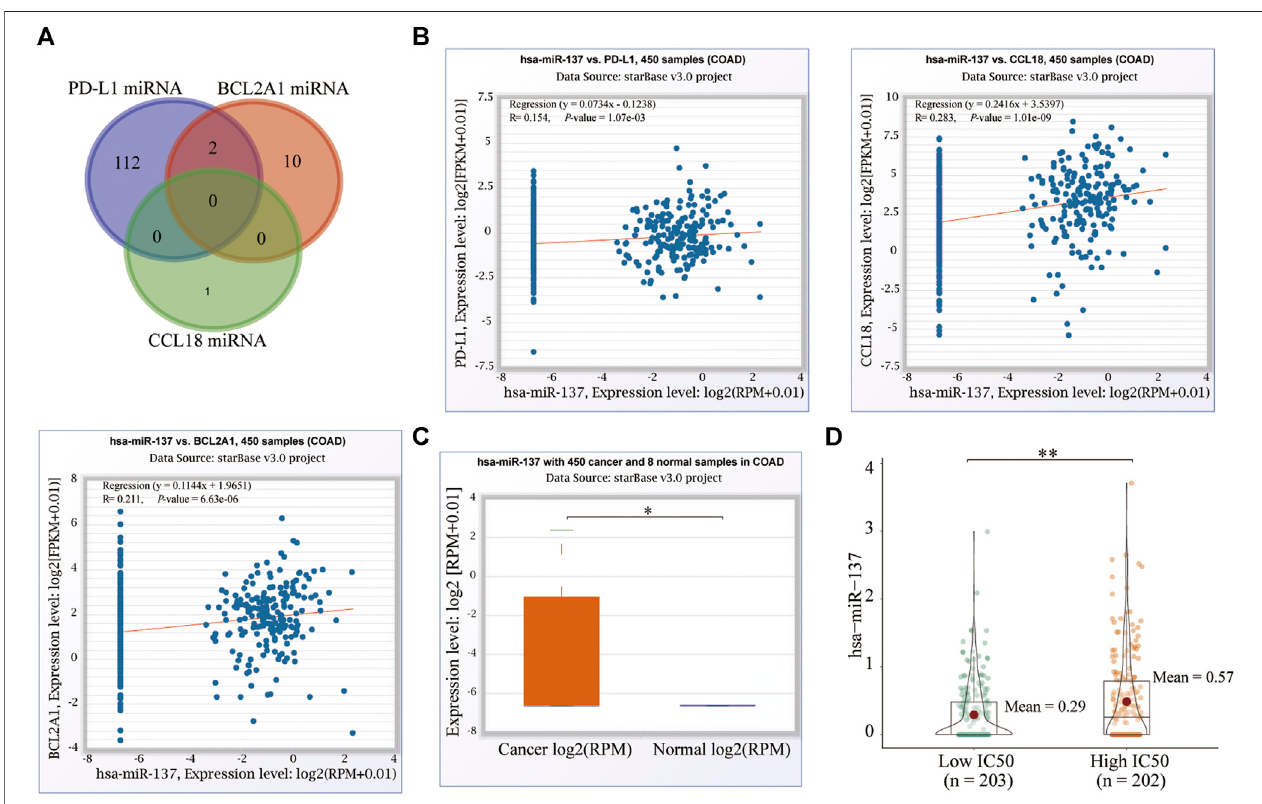
FIGURE 12 | MicroRNAs correlation and (A) shared miRNAs of PD-L1, CCL18, and BCL2A1. (B) One of the common miRNAs of PD-L1 and BCL2A1, hsa-miR- 137,wassigni fi cantlyrelatedtoPD-L1,BCL2A1,andCCL18. (C) Hsa-miR-137wassigni fi cantlyupregulatedinCCtissuesandthehighIC50group.* p < 0.05,** p < .01.